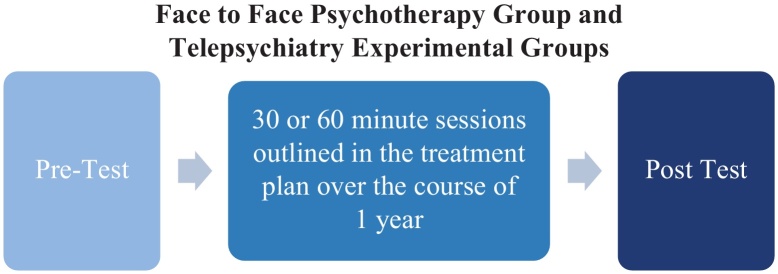
Study flow chart.